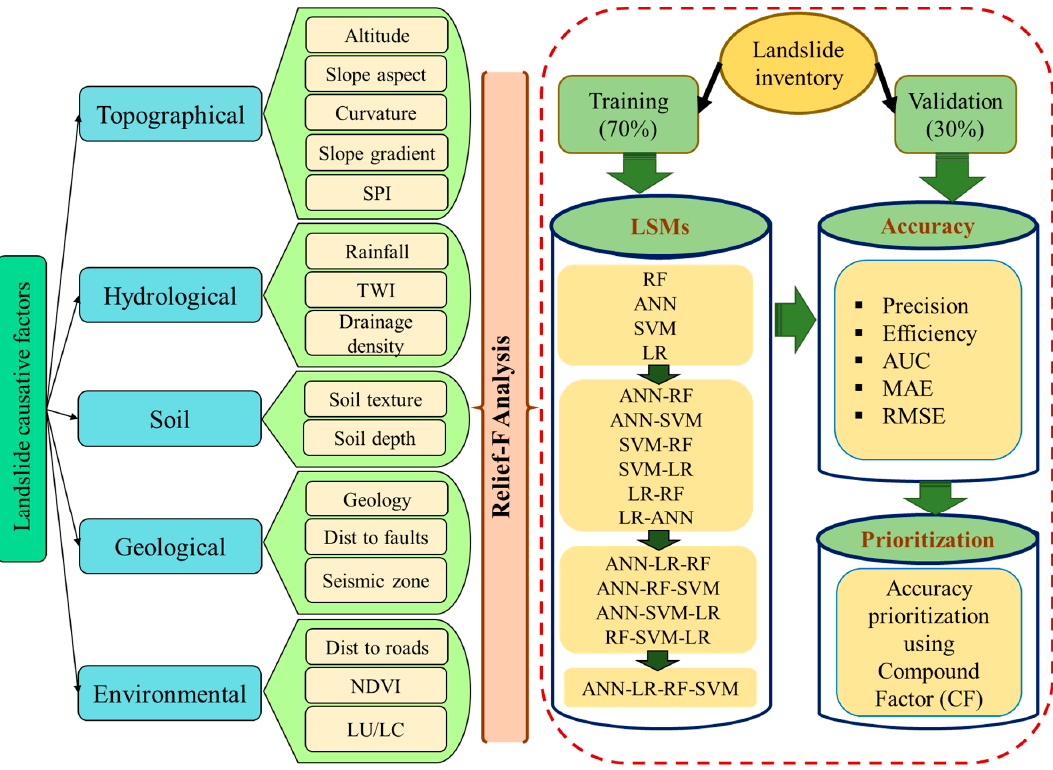
Figure 2. Methodological flow diagram of the present research. SPI (stream power index); TWI (topographical wetness index); NDVI (normalized difference vegetation index); LU/LC (land use/land cover).